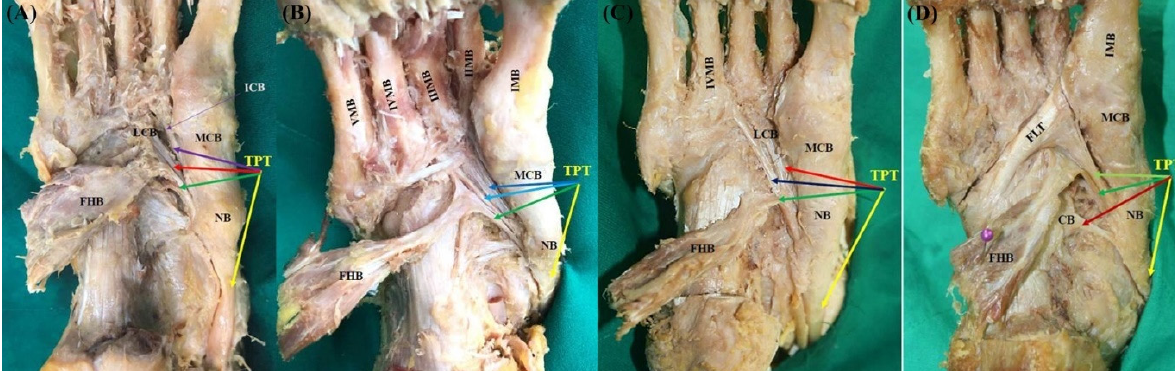
Figure 6. Photo of the Type 4 tibialis posterior tendon insertion. Yellow-colored arrow indicates main tendon inserts to the navicular bone and the medial cuneiform bone. ( A ) Type 4K-1. The first accessory tendon inserts to the intermediate cuneiform bone (purple-colored arrow). The second accessory tendon inserts to the lateral cuneiform bone (red-colored arrow). The third accessory tendon inserts to medial arm of the fibrotendinous origin of the flexor hallucis brevis muscle (green-colored arrow). ( B ) Type 4K-2. The first accessory tendon inserts to the second metatarsal bone (blue-colored ar- row). The second accessory tendon inserts to the second, third, fourth, fifth metatarsal bones (sky-blue-colored arrow). The third accessory tendon inserts to medial arm of the fibrotendinous origin of the flexor hallucis brevis muscle (green-colored arrow). ( C ) Type 4K-3. The first accessory tendon inserts to the lateral cuneiform bone (red-colored ar- row). The second accessory tendon inserts to the fourth metatarsal bone (navy-colored arrow). The third accessory ten- don inserts to medial arm of the fibrotendinous origin of the flexor hallucis brevis muscle (green-colored arrow). ( D ) Type 4K-4. The first accessory tendon is conjoined with the fibularis longus tendon and insert together to the first meta- tarsal bone (yellow-green-colored arrow). The second accessory tendon inserts to the cuboid bone (red-colored arrow). The third accessory tendon inserts to medial arm of the fibrotendinous origin of the flexor hallucis brevis muscle (green-colored arrow). TPT, tibialis posterior tendon; NB, navicular bone; MCB, medial cuneiform bone; LCB, lateral cuneiform bone; ICB, intermediate cuneiform bone; II, III, IV, V MB, second, third, fourth, fifth metatarsal bones; FHB, flexor hallucis brevis.